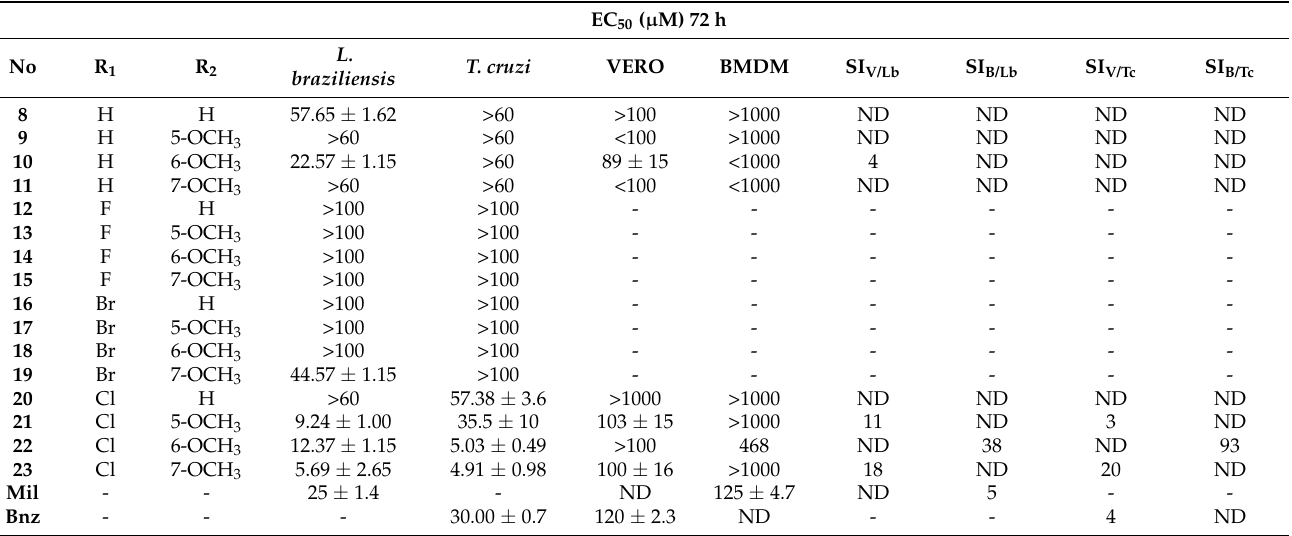
Table 1. Effect of compounds 8 – 23 on the viability of promastigotes of Leishmania (V.) braziliensis , epimastigotes of Trypanosoma cruzi , BMDM macrophages, and VERO cells. EC 50 ( µ M) 72